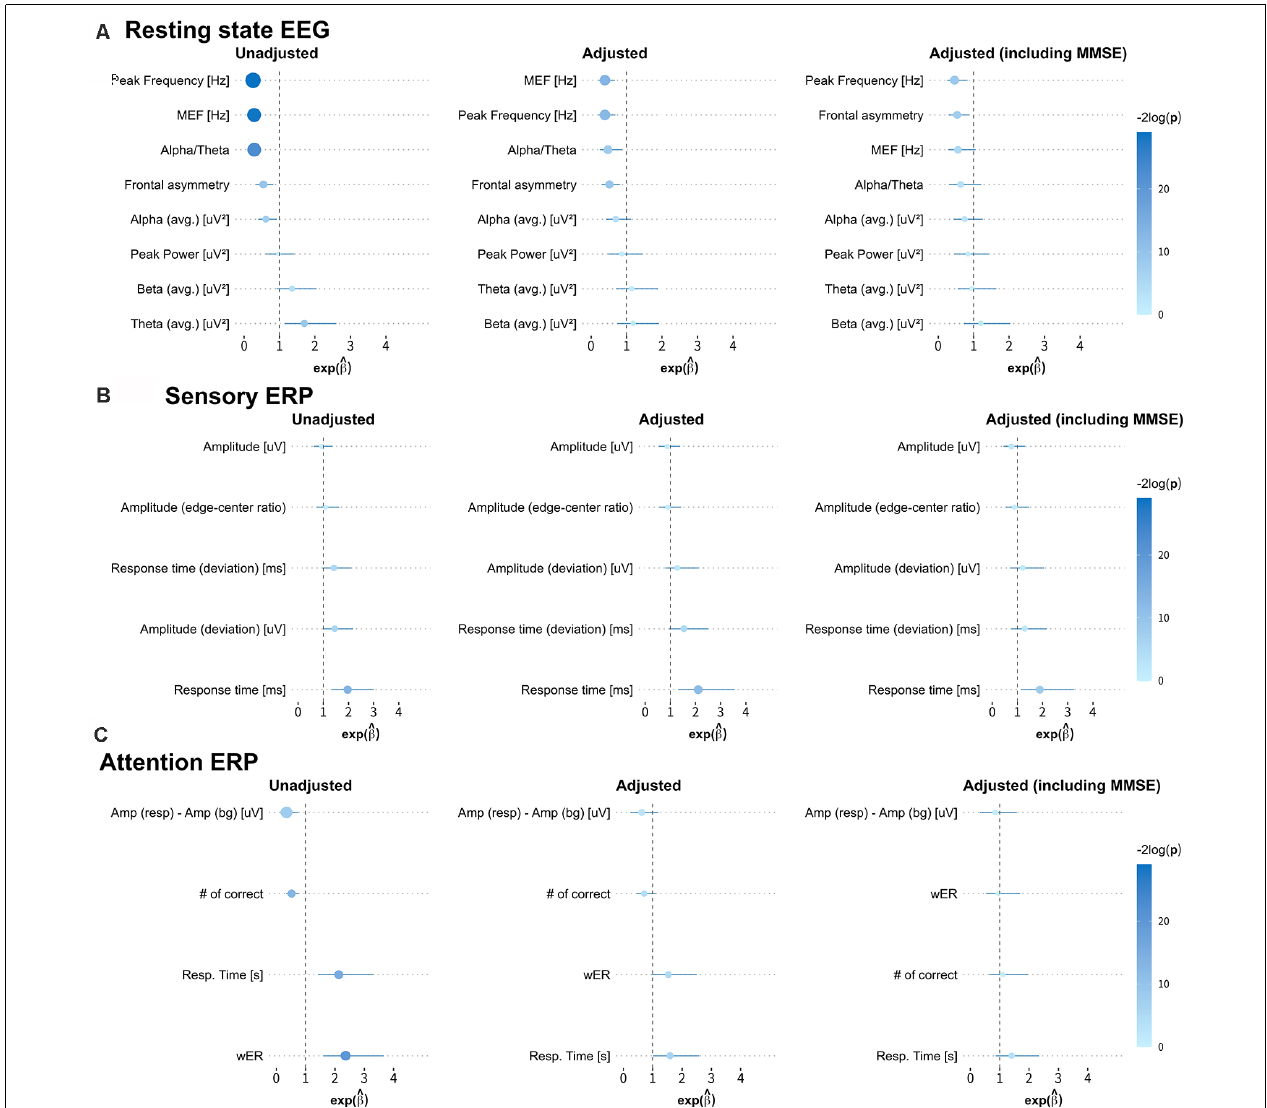
FIGURE 4 | Estimated odds ratios and 95% confidence intervals derived from three logistic regression models. The first, second, and third columns show the results from the unadjusted univariate logistic regression model; the model adjusted for sex, age, education level, and geriatric depression scale (GDS) score; and the model adjusted for all these covariates and the MMSE score, respectively. The size of each circle indicates the magnitude of the estimated odds ratio, and the line across the circle represents its 95% confidence interval. The color map represents the magnitude of the log-transformed p -values ( − 2log p) for the odds ratios (MEF, median frequency; wER, weighted error percentile). The quantitative results are summarized in Appendix Table A1